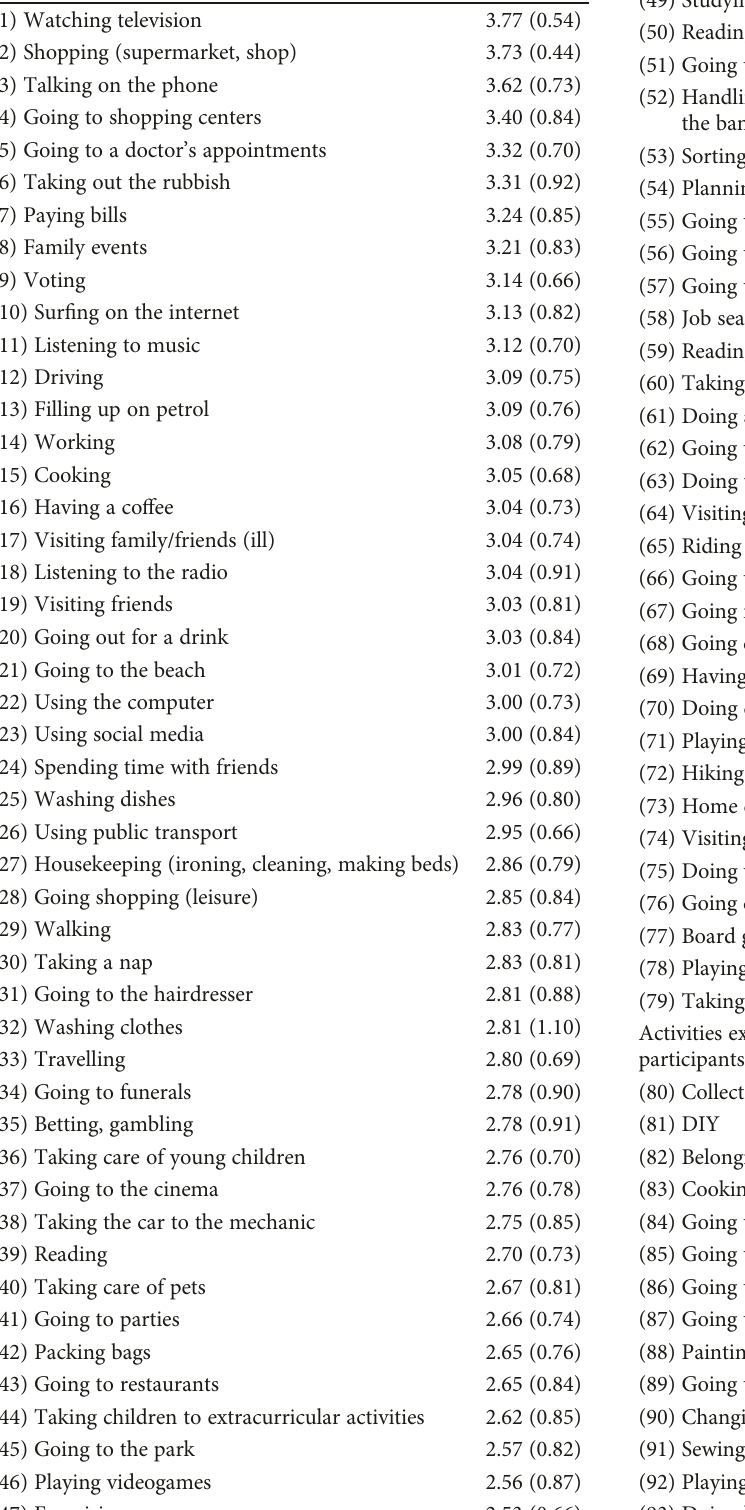
Table 2: Activities included and excluded in the fi nal version of the ACS-SP ordered according to the frequency estimated by participants ( n = 79 and n = 24 ,